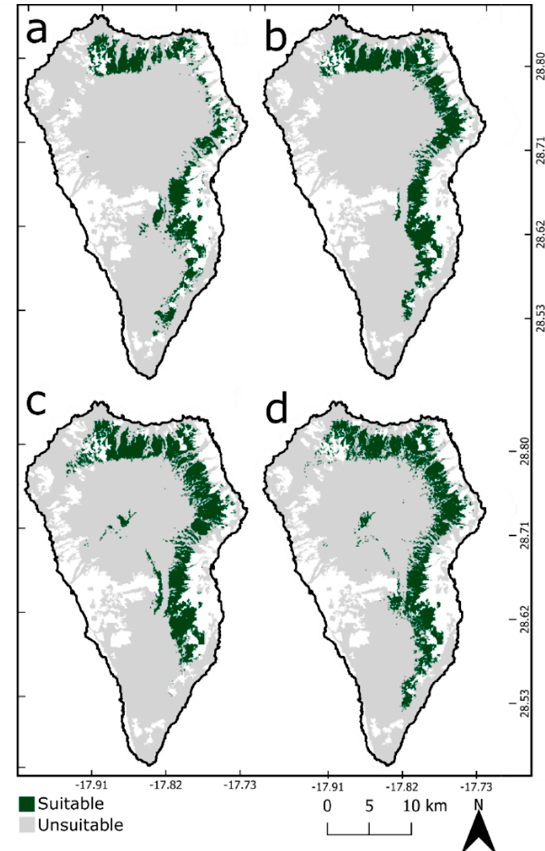
Figure A8. C. sativa presence absence maps ( a ) from the Random Forest (RF) field-collected species occurrence locations, ( b ) from the Random Forest (RF) based on the RS species occurrence locations, ( c ) from the Generalized Additive Linear Model (GAM) based on the remote sensing (RS) species occurrence locations and ( d ) from the Maximum Entropy (MaxEnt) Model based on the RS species occurrence locations.